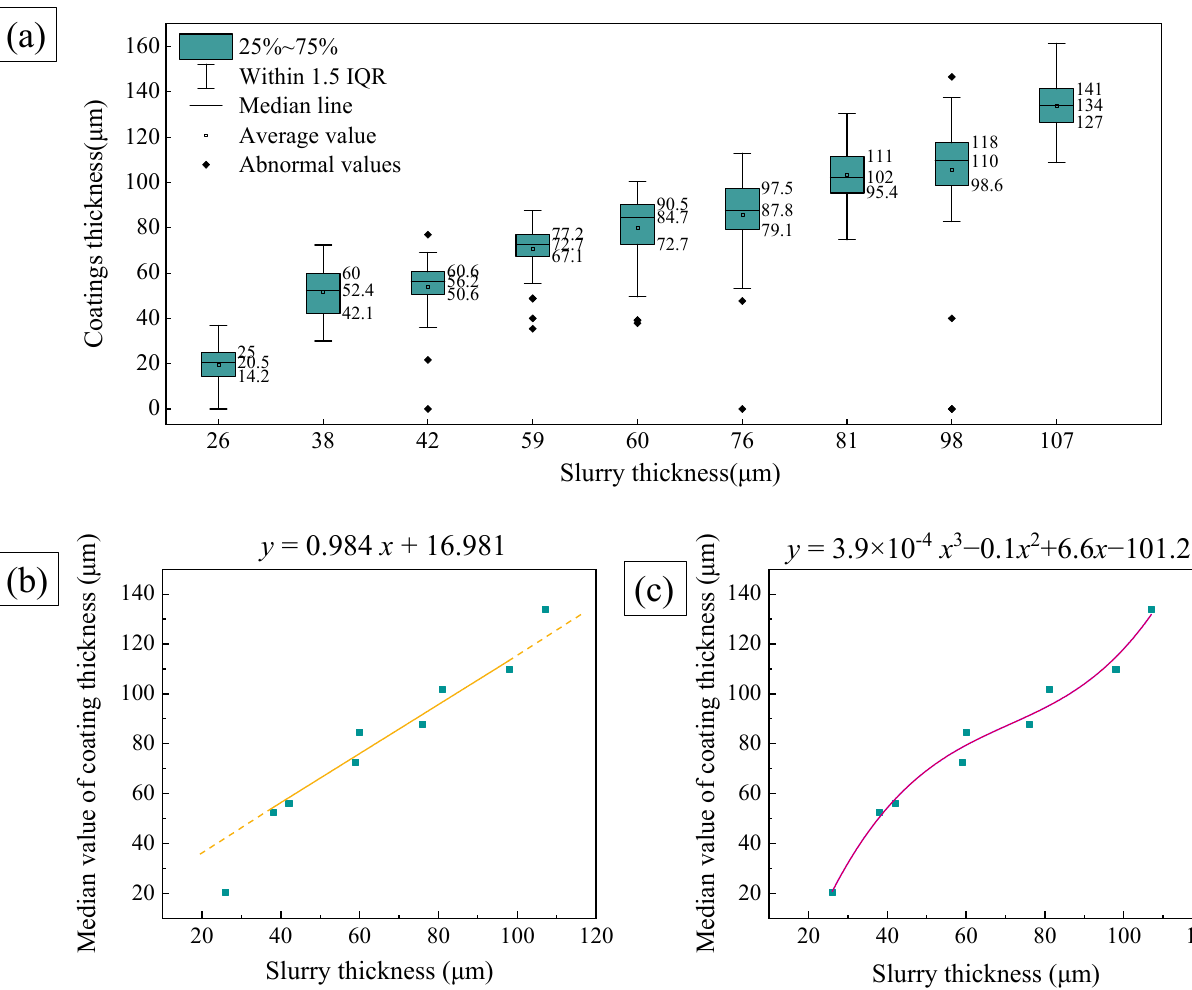
Figure 3. Relationship between slurry thickness and coating thickness. ( a ) Box plot of slurry thickness vs. coating thickness; ( b ) linear fitting curve of slurry thickness and coating thickness; and ( c ) cubic polynomial fitting curve of slurry thickness and coating thickness.